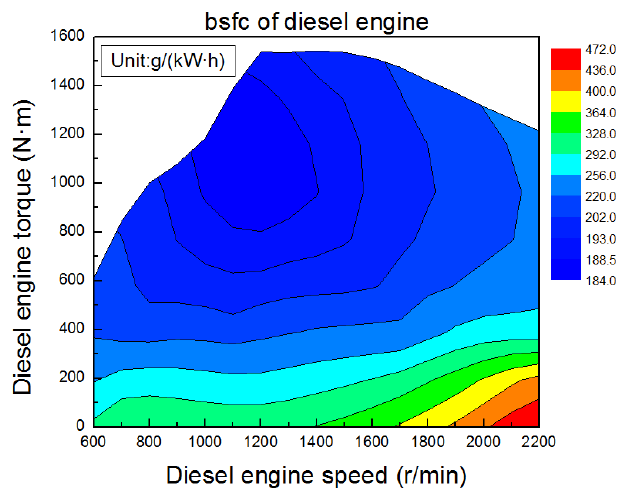
Figure 2. BSFC of the diesel engine.